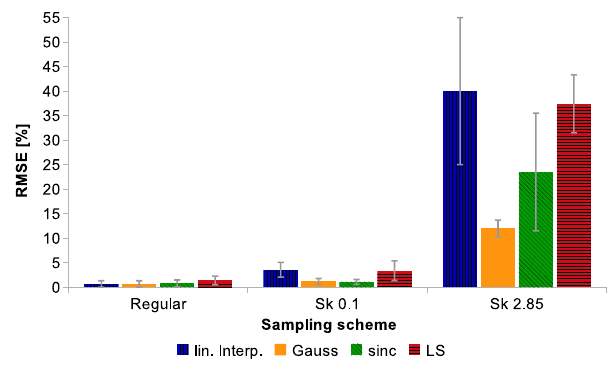
Fig. 5. Mean RMSE for the ACF estimation (lags 1–3) using lin- ear interpolation, Gaussian or sinc kernel or the inversion of the Lomb-Scargle periodogram of noise-free sinusoids given for reg- ular, gamma-distributed and mildly irregular (skewness sk=0.1) resp. very irregular (sk=2.85) sampling. Errorbars give the stan- dard deviation of the estimate, calculated using 1000 bootstrap iter-